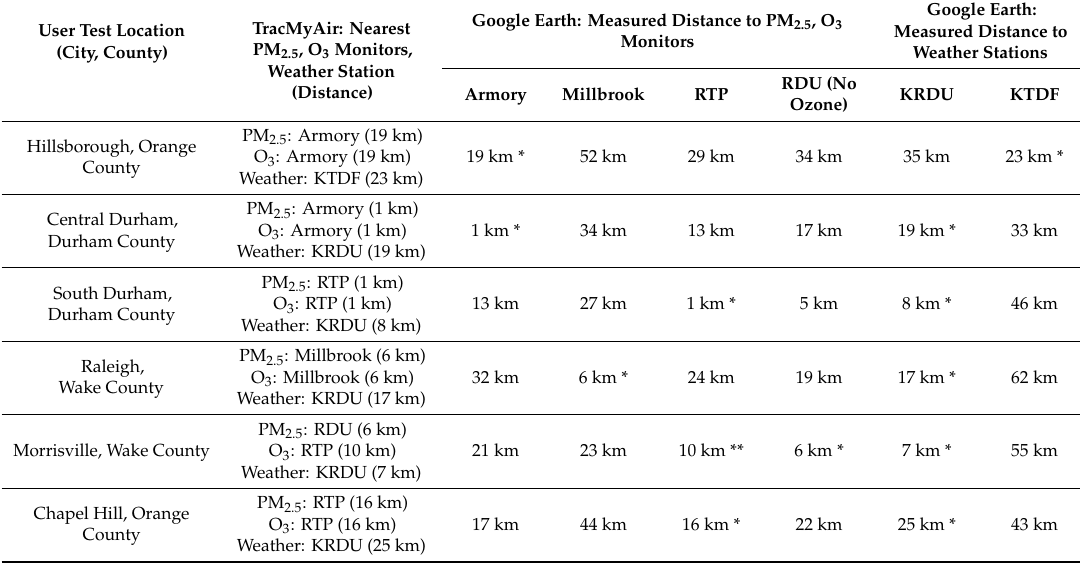
Table 5. Evaluation of TracMyAir automated inputs for nearest outdoor air pollution monitors and weather stations.